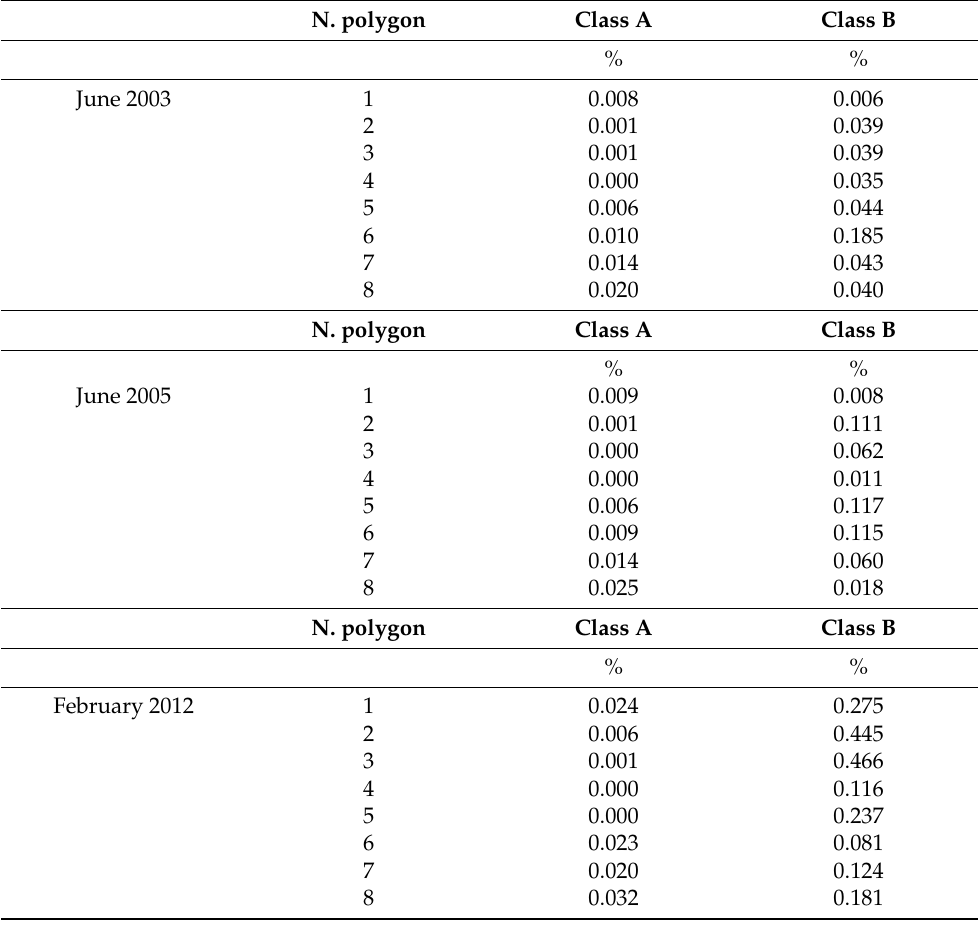
Table 1. Percent area occupied by vegetation types A (trees) and B (dense